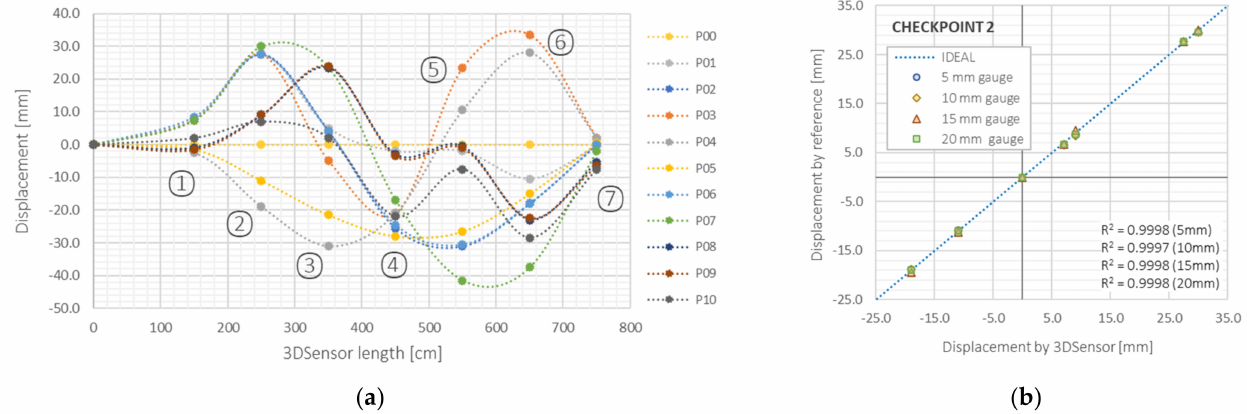
Figure 20. 3DSensor in the scheme of continuous beam: ( a ) example displacements profiles with checkpoint reference values (1–7); ( b ) comparison between 3DSensor and reference displacements at checkpoint no.